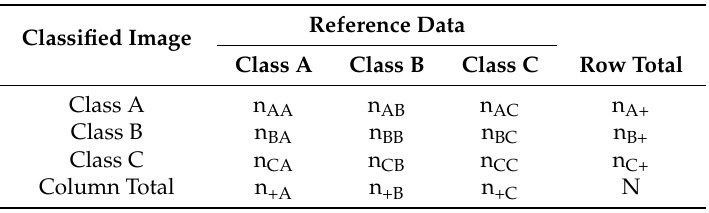
Table 4. Layout of the confusion matrix.